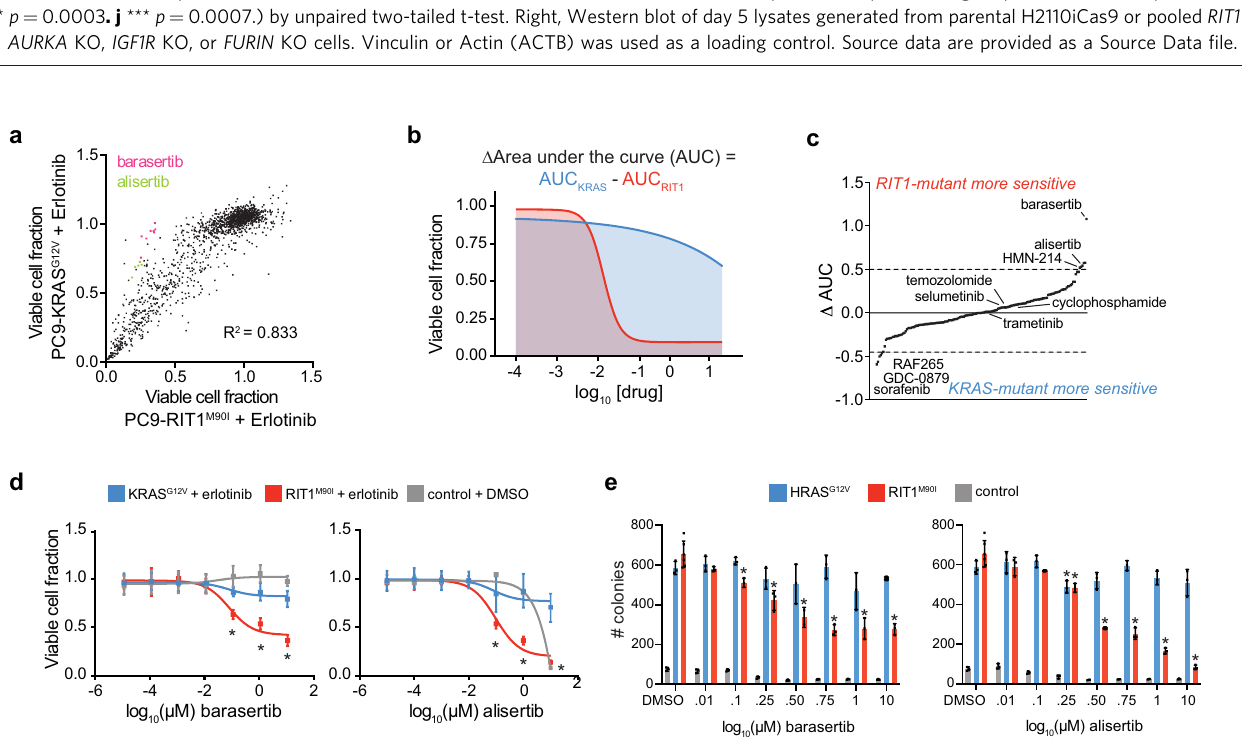
Fig. 4 RIT1 -mutant cells are vulnerable to loss of RAS pathway and cell cycle genes. a Heatmap illustrating the CS of selected dependencies clustered by biological pathway. Each column is a different replicate and shows CS between erlotinib or DMSO versus plasmid. b MSigDB overlap analysis of the GO Biological Process gene sets signi fi cantly enriched in the top 500 PC9-Cas9-RIT1 M90I and PC9-Cas9-KRAS G12V essential genes. c – e Left, 96-hour dose – response curve of erlotinib in clonal SHOC2 knockout (KO), AURKA KO, or USP9X KO cells derived from PC9-Cas9-RIT1 M90I cells. The same data for control and PC9-Cas9-RIT1 M90I and RIT1 KO cells are plotted on each panel for reference. Data shown are the mean ± s.d. of two technical replicates. Right, Western blot for SHOC2, AURKA, or USP9X expression in clonal knockout cells derived from PC9-Cas9-RIT1 M90I cells. Vinculin was used as a loading control. f Area-under-the-curve (AUC) analysis of data from panels ( c – e ). g-j Left, Cumulative population doublings of H2110iCas9 cells grown in the presence of doxycycline ( + dox) expressing the indicated sgRNAs compared to cells expressing non-targeting control sgRNA (sgNTC). The same data for sgNTC is shown on each panel for reference. Data shown are the mean ± s.d. of three technical replicates. *** p < 0.001 ( g *** p = 0.0005 . h *** p = 0.001.